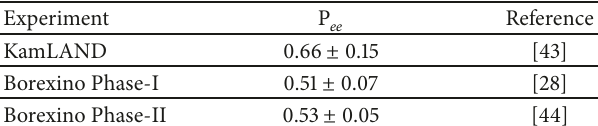
Table 2: Solar electronic neutrino survival probability measured by various experiments for 7 Be neutrinos.